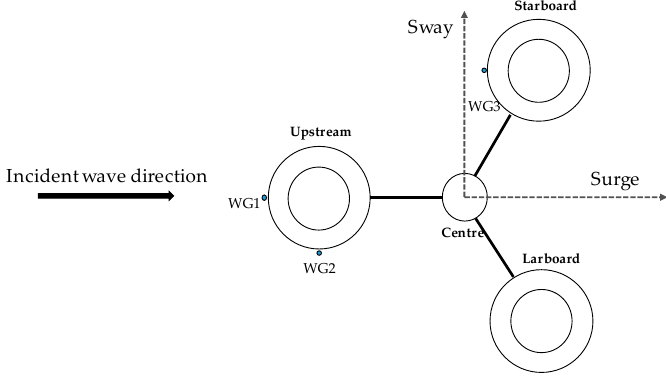
Figure 14. Sketch of wave gauge settings for a fixed semi-submersible platform.